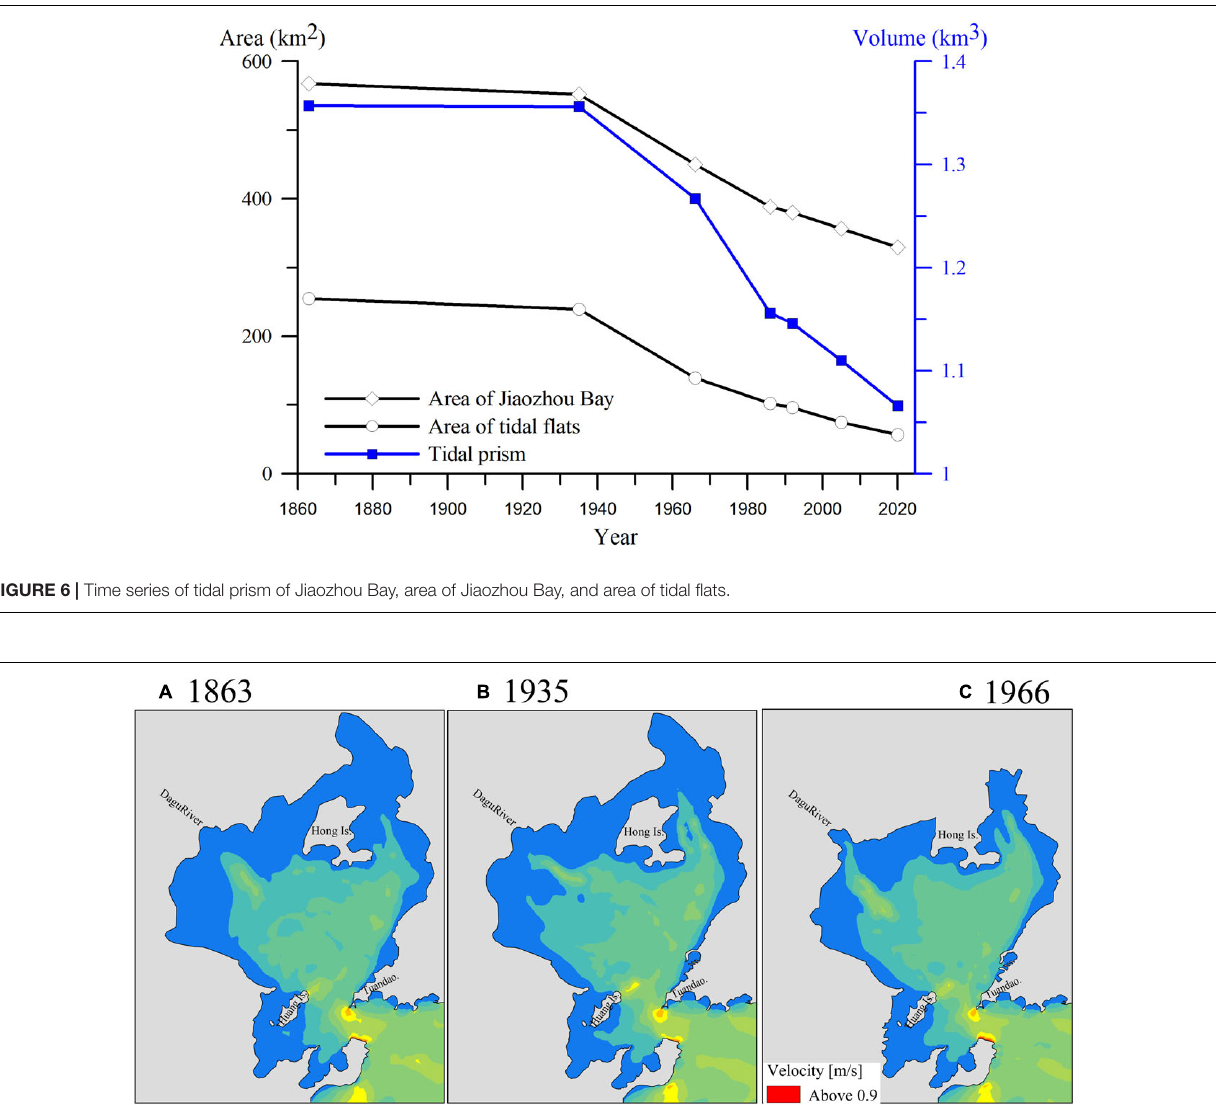
Frontiers in Marine Science |